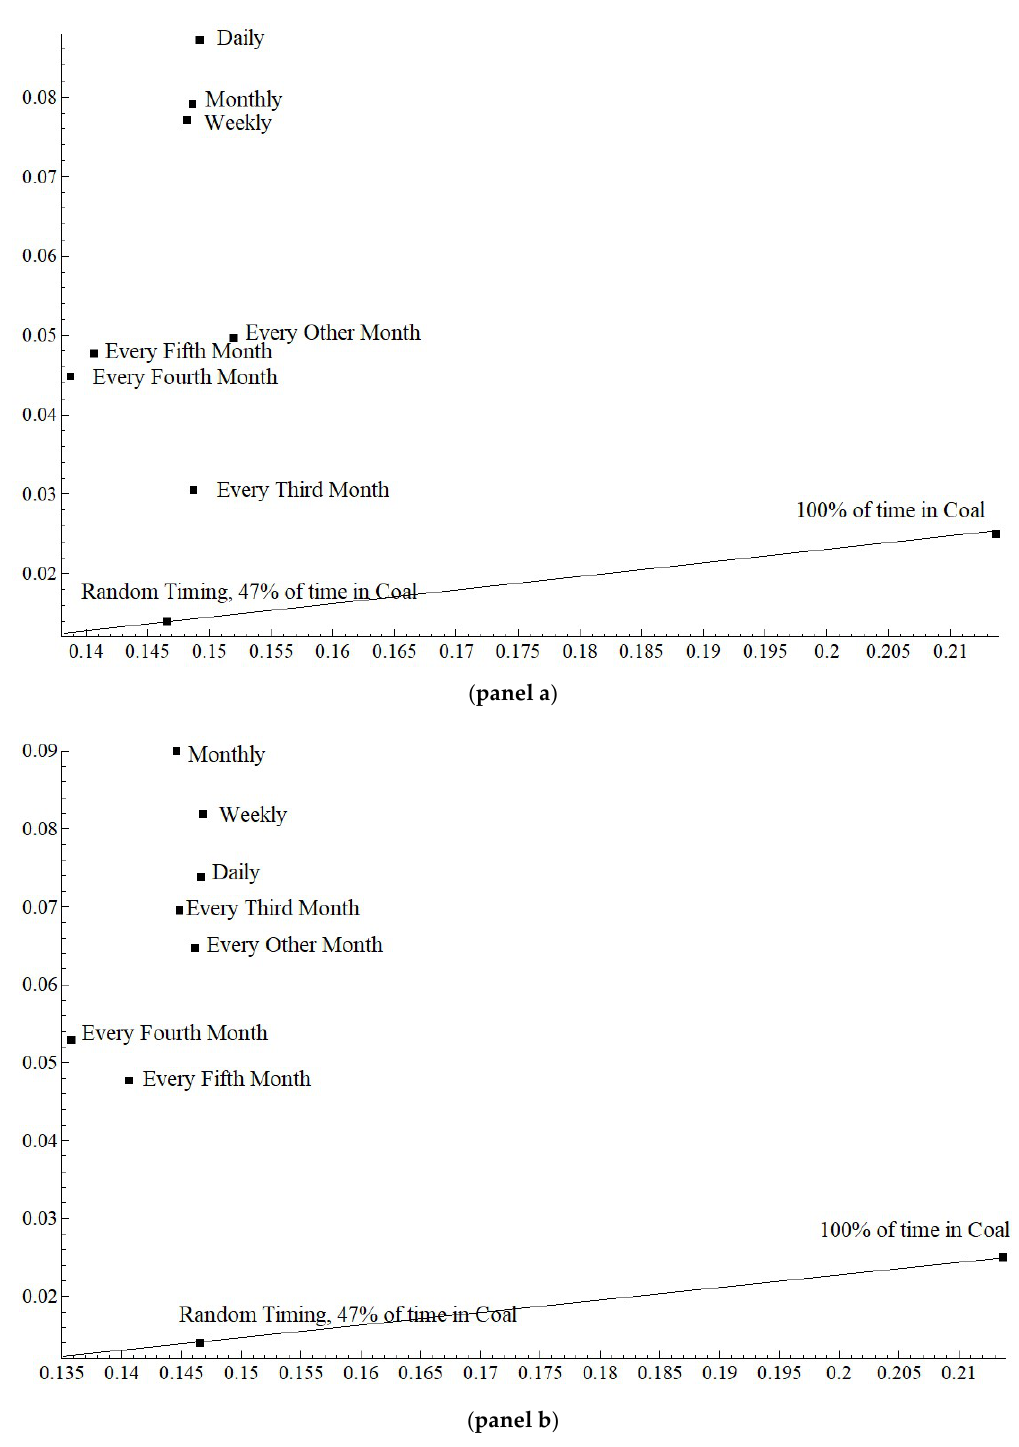
Figure 6. Returns to volatility ratios in coal futures, 2 December 2008 to 28 September 2018, compared with random timing. ( panel a ) Calculated daily, weekly, monthly, every second month, every third month, every fourth month, and every fifth month; ( panel b ) Calculated with maximal rolling window, daily (MA200), weekly (MAW40), monthly (MA10), every second month (MAD5), every third month (MAT4), every fourth month (MAQ3), and every fifth month (MAC2).